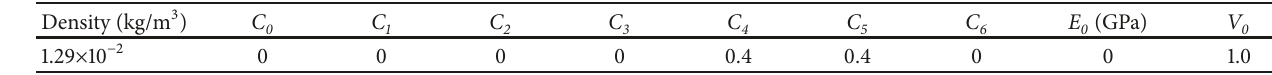
Table 6: Material model and state equation parameters of the